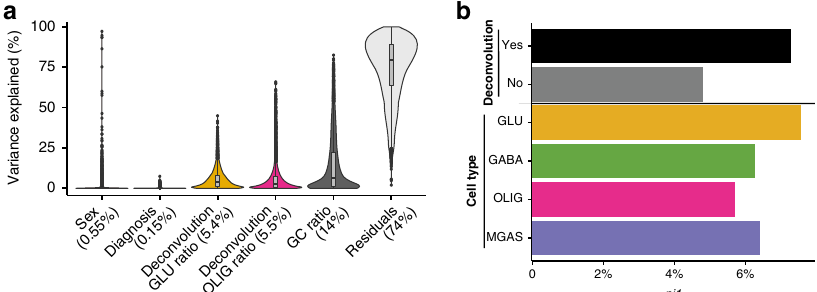
Fig. 6 Using cell-speci fi c OCRs for deconvolution of bulk ATAC-seq data. a Violin plot illustrating the proportion of variation in chromatin accessibility explained by biological, technical, and cell-type deconvolution covariates. The GC ratio can be considered a signal to noise parameter. Numbers in parentheses indicate the median. b In various scenarios the proportion of non-null tests, pi1 , was estimated for OCRs. Higher estimates indicate more signi fi cant differences between schizophrenia cases and controls. First, the effect of deconvolution on the pi1 was assessed, and the addition of a deconvolution parameter was seen to increase power to detect case-control differences. Secondly, the pi1 estimates were calculated in just cell-speci fi c OCRs. Here the largest case-control differences were seen in GLU-speci fi c OCRs.